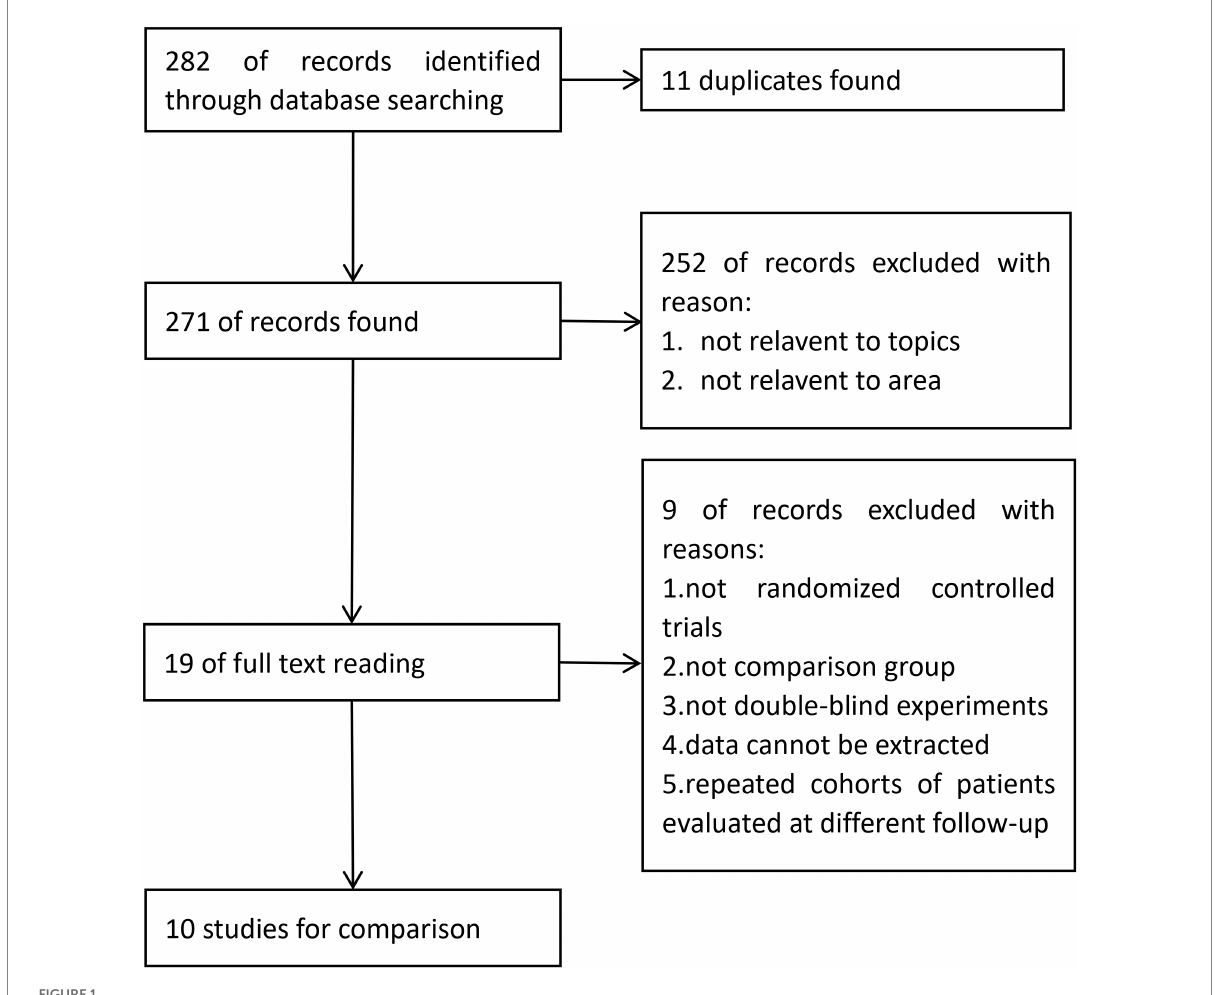
FIGURE 1 Flow diagram of trial selection in this